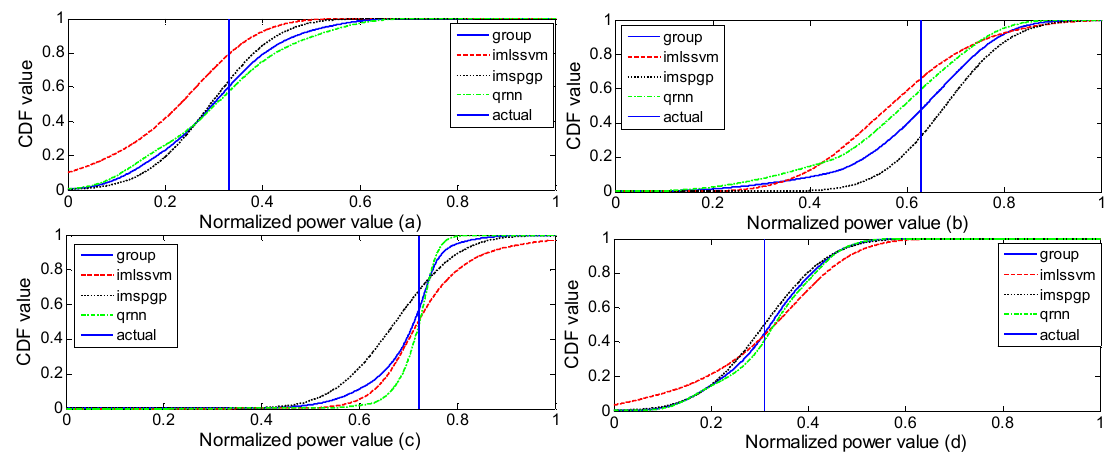
Figure 9. Comparison of point prediction error over seven days.